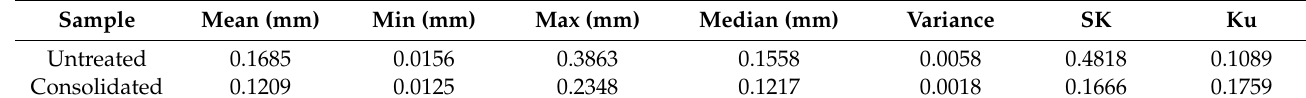
Table 2. Comparison of equivalent diameter distribution of pores.